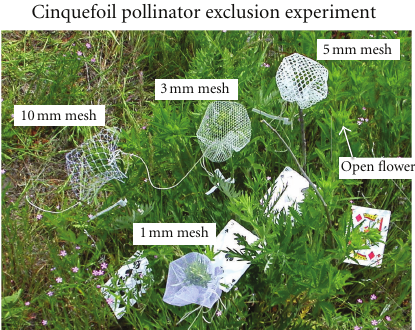
Figure 2: Photograph of a block of the five treatments deployed in the cinquefoil pollinator exclusion experiment: open flower (all access); 10 mm mesh size (sham cage, all access); 5 mm mesh (excludes large pollinators); 3mm mesh (excludes large and medium pollinators); 1mm mesh (excludes large, medium, and small